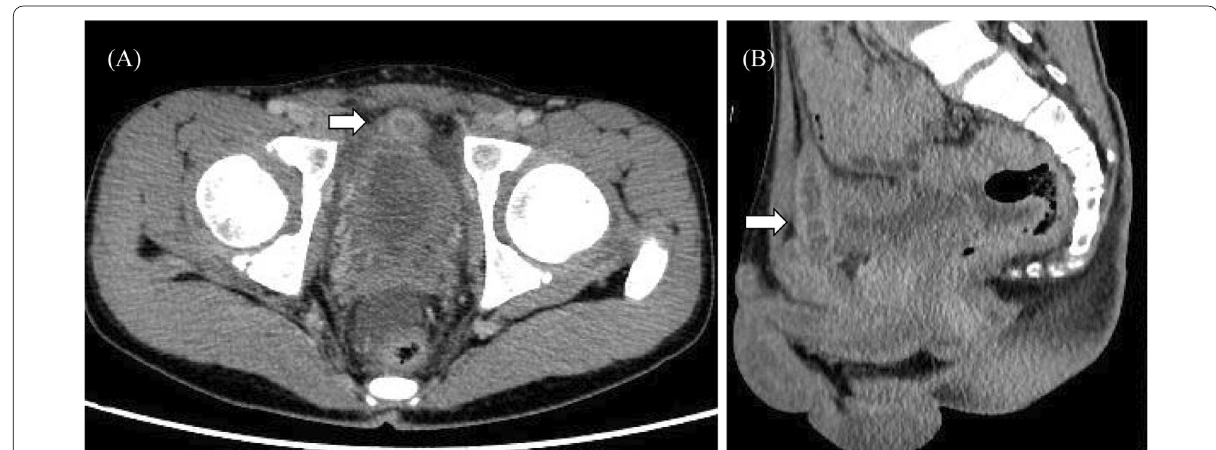
Fig. 2 Computed tomography revealed an abscess inside a fistula lumen on the posterior surface of the rectus abdominis muscles in the midline of the lower abdomen (arrows) ( A : axial B :